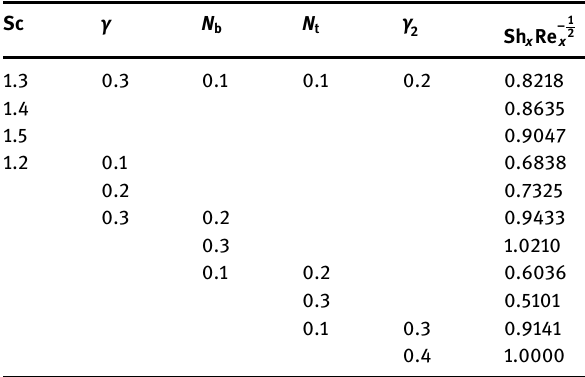
Table 5: Numerical values of the Sherwood number Sh Re